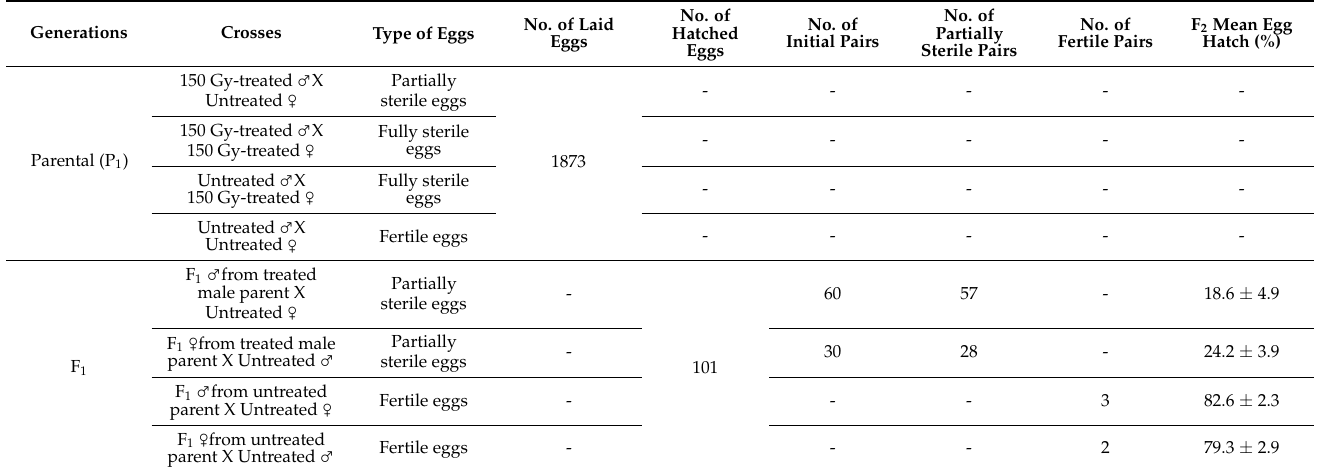
Table 3. Fertility of L. botrana F 2 male and female moths resulting from 150 Gy-treated male mated to untreated female or untreated male mated with untreated female moths (parental generation) when released in a oviposition cage of 1.1 m 3 at 1: 1: 10: 10